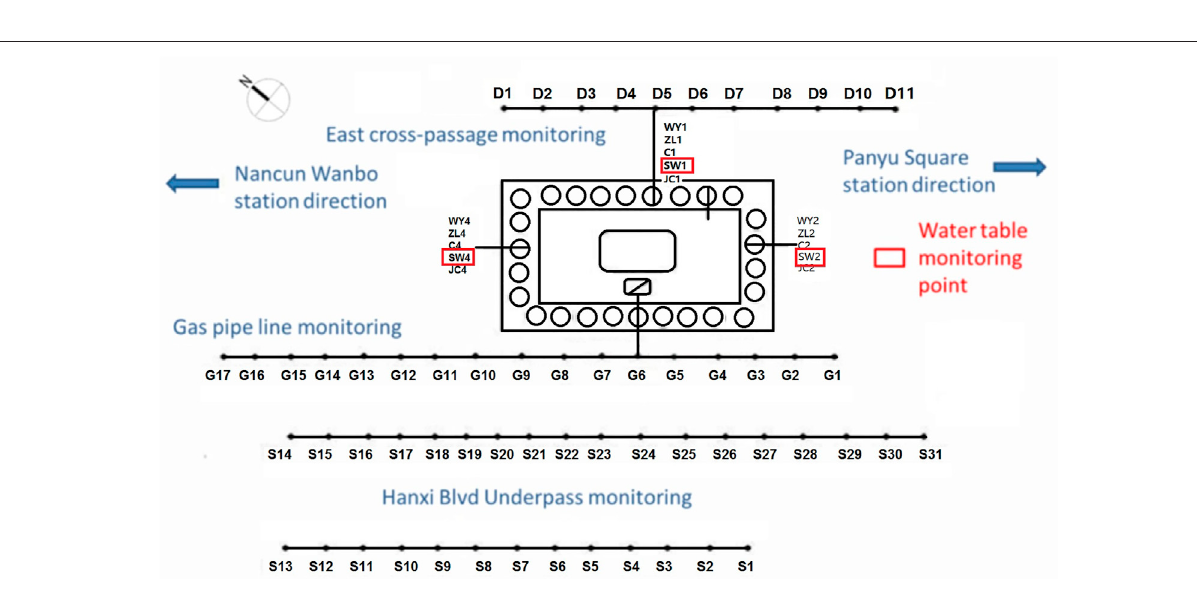
Frontiers in Earth Science |